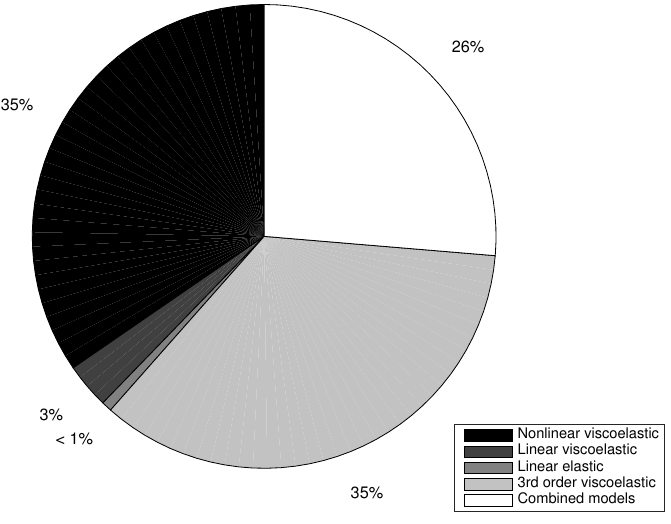
Figure 6. Ranking of model hypothesis.